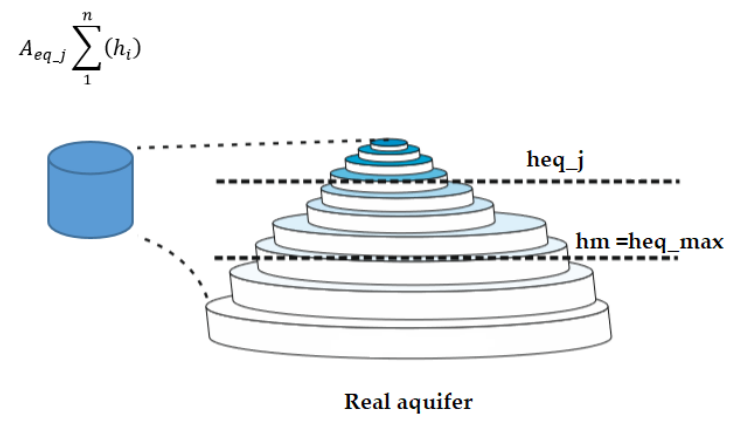
Figure 6. Representation of the recharge area redistribution model on the real topographic surface, starting from the top of the relief. This area refers to the equivalent regular aquifer dependent from flow rate (Equation (3)). The non-uniform redistribution was made using the Weibull cumulative probability function (Equation (4)), with the aim to detect the recharge area involved in the real aquifers.